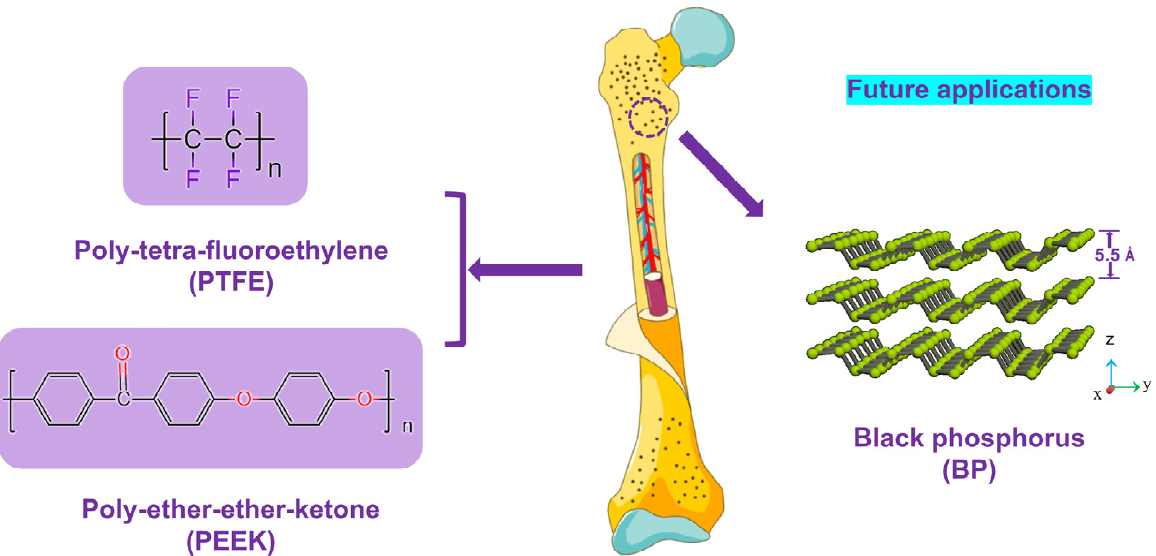
Figure 1. The schematic diagram and future applications of the PEEK/PTFE/BP artificial bone